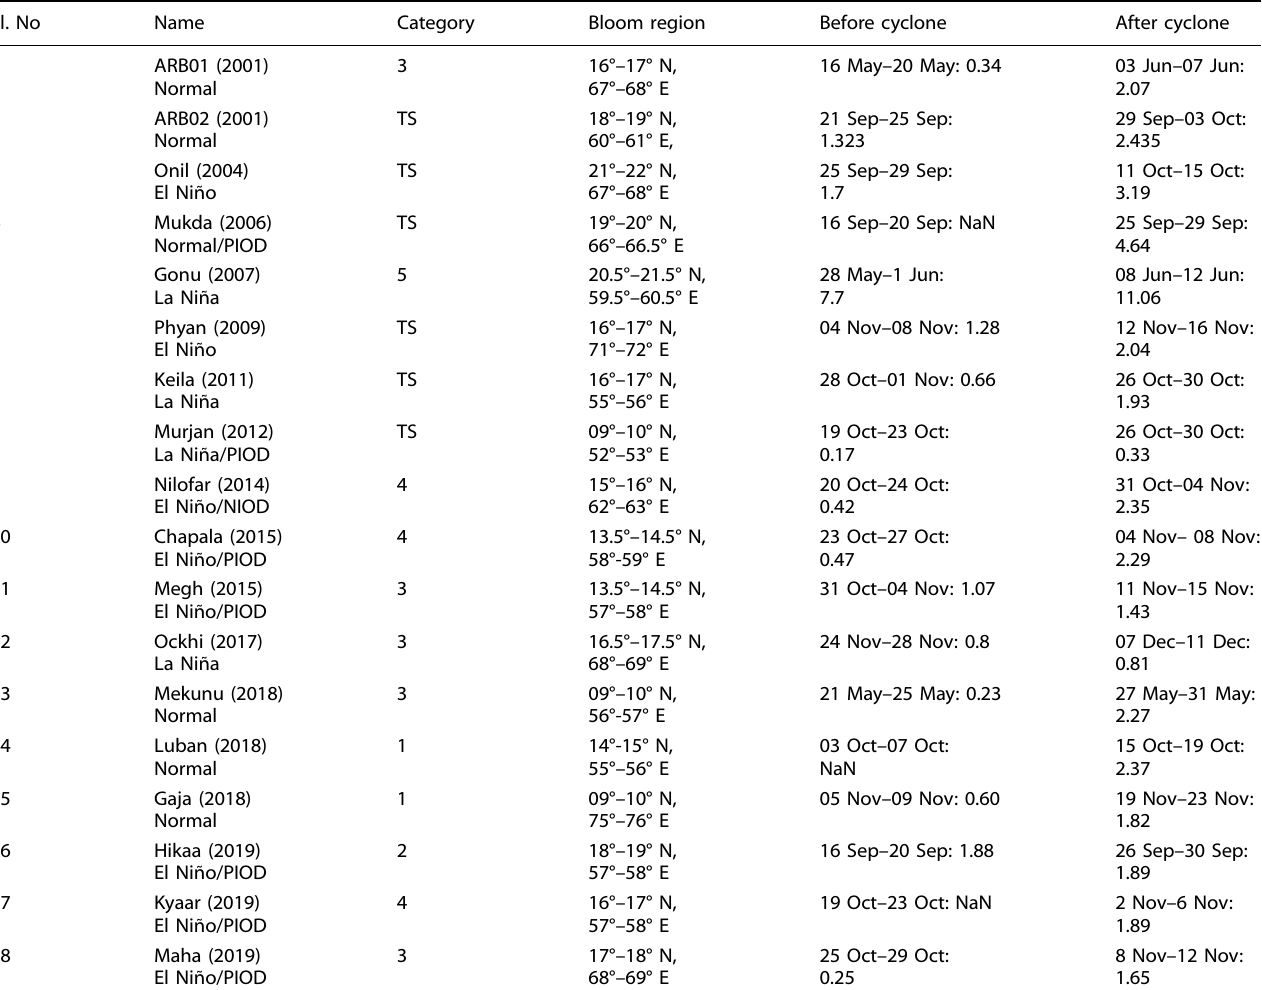
Table 2. The cyclone-induced Chl-a blooms in the post-monsoon seasons since 1997 in AS. Sl.